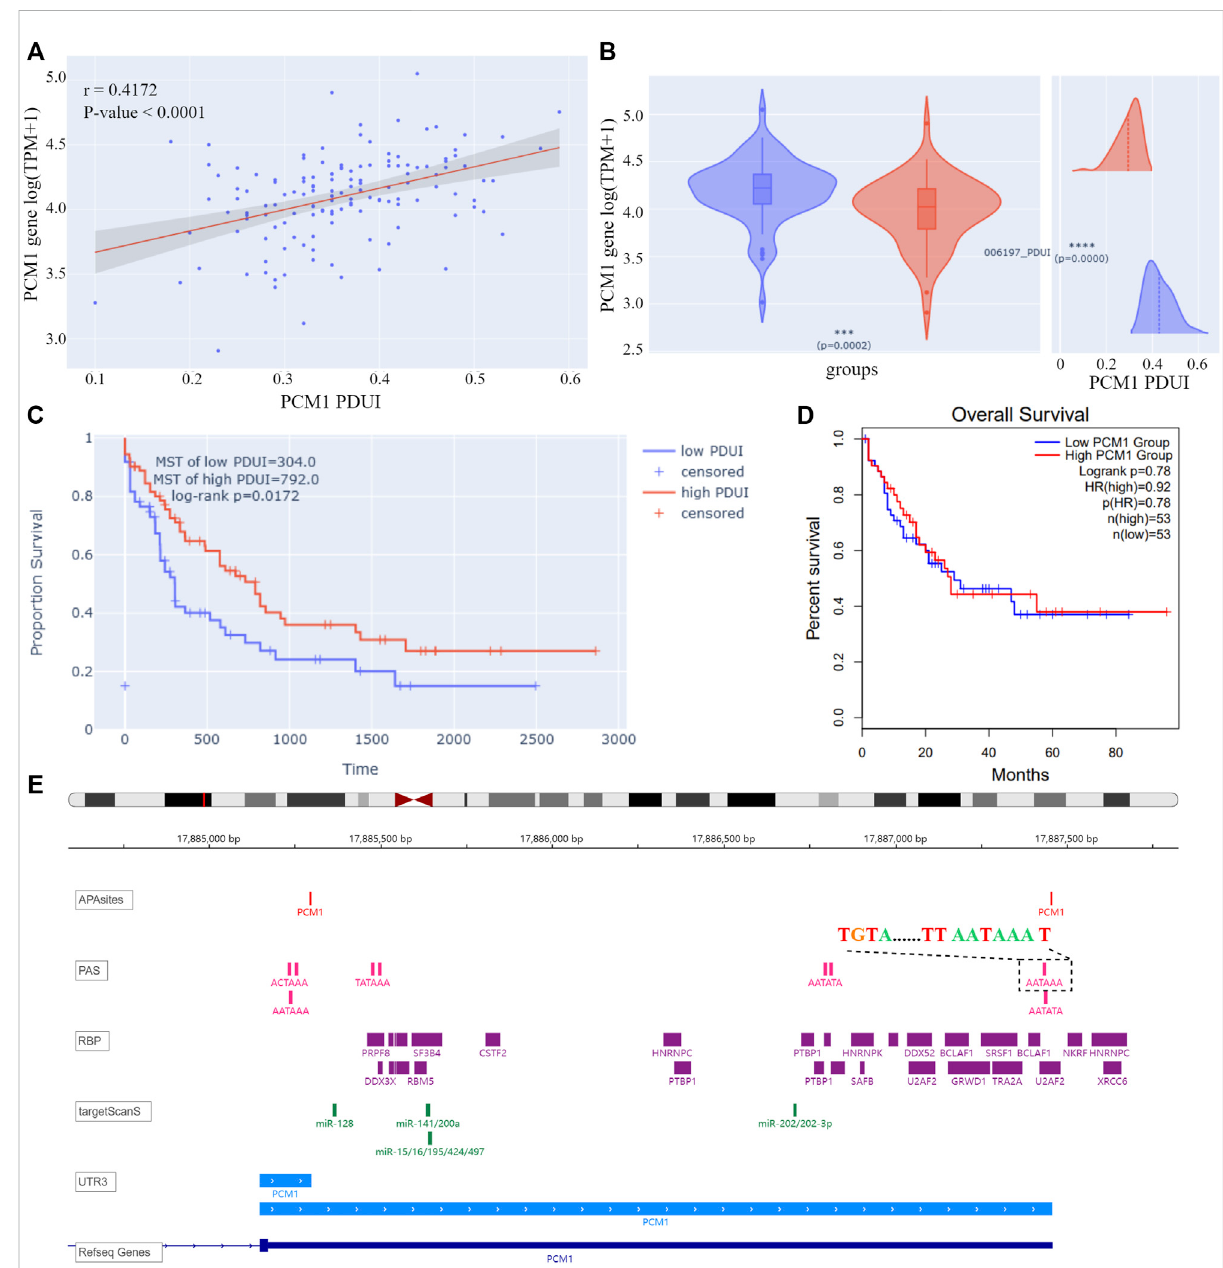
FIGURE 4 (A) Correlation analysis result of PCM1 PDUI and gene expression. The X-axis represents PDUI of PCM1; the Y-axis represents expression of PCM1. Each dot in the scatter plot represents an AML sample. The red line is the regression curve, and the gray region shows its 95% con fi dence interval. (B) Box plot of PCM1 expression and density plot of PCM1 PDUI in the high-PDUI group (blue) and low-PDUI group (red). Dashed lines representmeanvalues ofPDUI ingroups.*** p -value < 0.001,**** p -value < 0.0001. (C) KMcurveofPCM1low-PDUIandhigh-PDUIgroupsin AML. Groups are divided by the median of PCM1 PDUI. Survival time is shown by days. (D) KM curve of PCM1 low-expression and high-expression groupsinAML.GroupsaredividedbythemedianofPCM1expressioninAML.TheplotisdownloadedfromGEPIA2.Survivaltimeisshownbymonths. (E) IGV plot of PCM1. The tracks from top to bottom are APA sites extracted from input data, PAS annotated by polyA DB3, RBP-binding regions annotated by ENCODE, miRNA-binding regions annotated by TargetScanHuman 7.2, 3 ′ UTR constructed by APA sites, and human genome from UCSC. The dashed box showed the PAS sequence upstream of the distal APA site of PCM1. PDUI, percentage of distal PolyA site usage index; MST, median survival time; PAS, PolyA site signal; RBP, RNA-binding protein; TPM, transcripts per kilobase million; HR, hazard